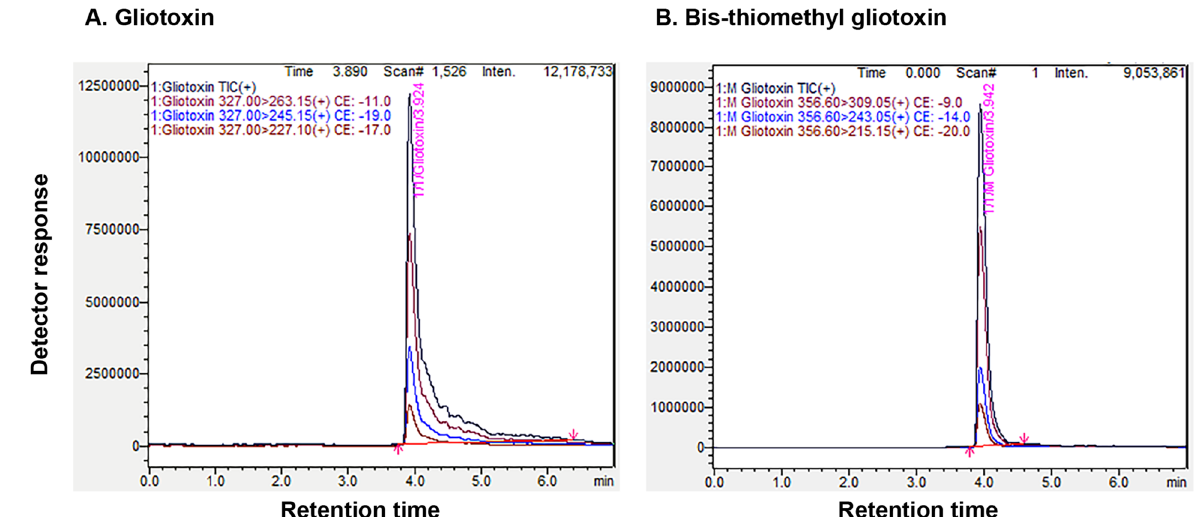
Figure 3. LC-Tandem MS analysis of gliotoxin and bis-thiomethyl gliotoxin. ( A ) gliotoxin; ( B ) bis-thiomethyl gliotoxin